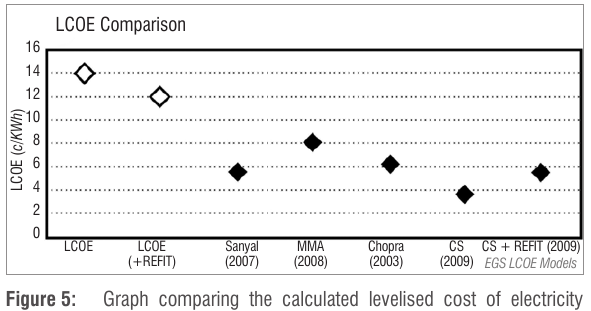
Figure 5: Graph comparing the calculated levelised cost of electricity (LCOE) of this study (white points) with the LCOE of other enhanced geothermal systems (black points).